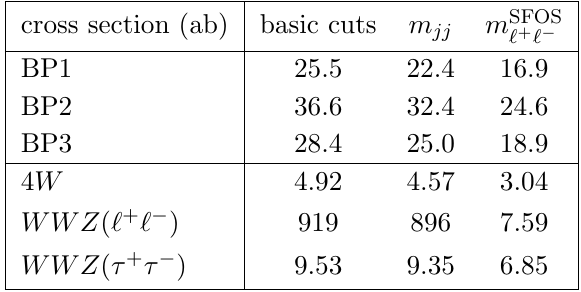
Table 3 . Cut (cid:13)ow of the signal and background cross sections in the ‘ (cid:6) ‘ (cid:6) ‘ (cid:7) jj channel. that with the combination of eq. (1.6). Alternatively, we would have (cid:14)(cid:21) WZ =(cid:21) WZ < 1 : 15 if the